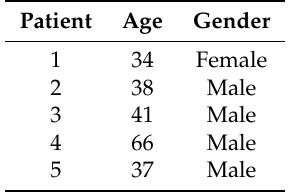
Table 1. Set of patients with spinal cord injury (SCI).